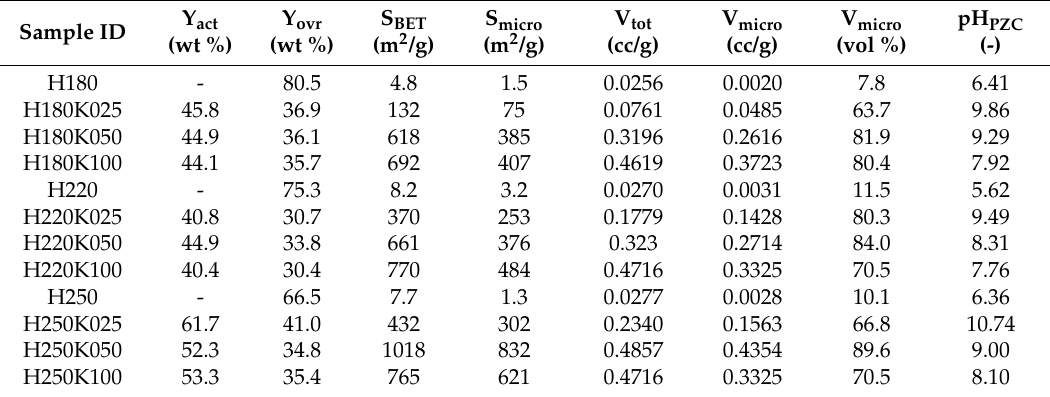
Table 2. Yields and textural characterization of the produced samples.